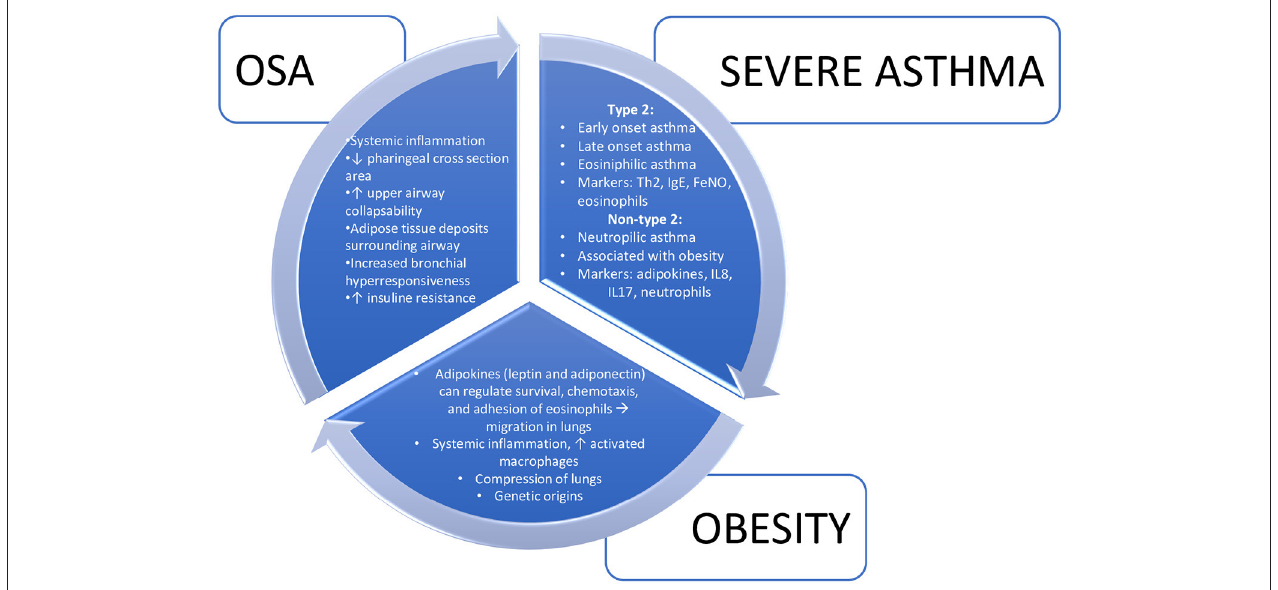
FIGURE 1 | Interrelationships between severe asthma, obesity, and obstructive sleep apnea.